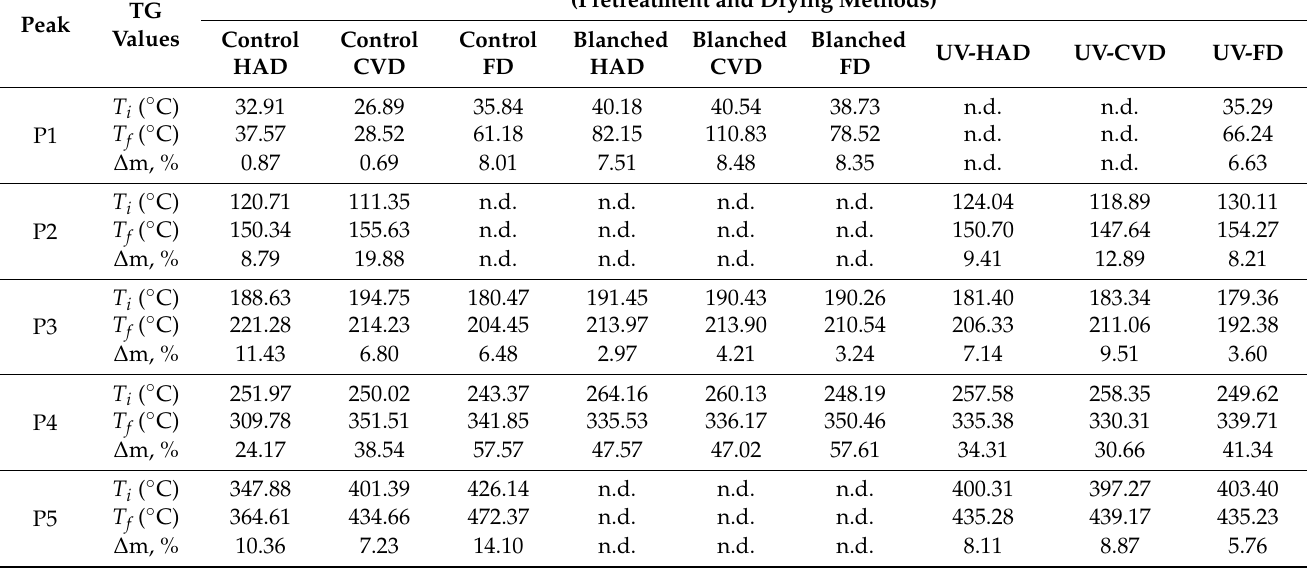
n.d. = not detected.